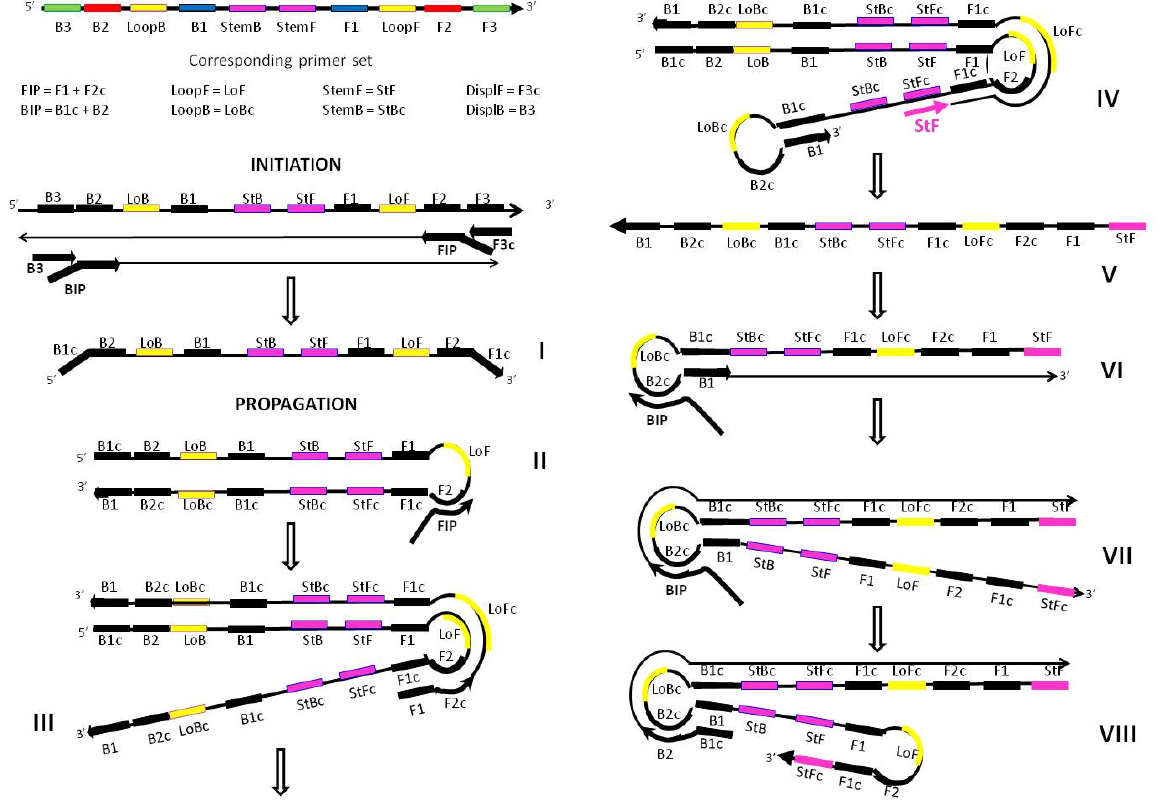
Figure 9. Proposed mechanism for the acceleration of LAMP amplification with Stem primers showing the potential location of all priming sites essential for the propagation of the amplicon (only one strand is shown for example purposes). Structures III, V and VIII depict the distinctive features of Stem primer’s action. Structure III has a transiently single strand available for the productive binding of the StemF primer. Structure V is the amplicon produced as a result of the extension of StemF primer. Structure VIII is self-extending through extra strong intra-molecular